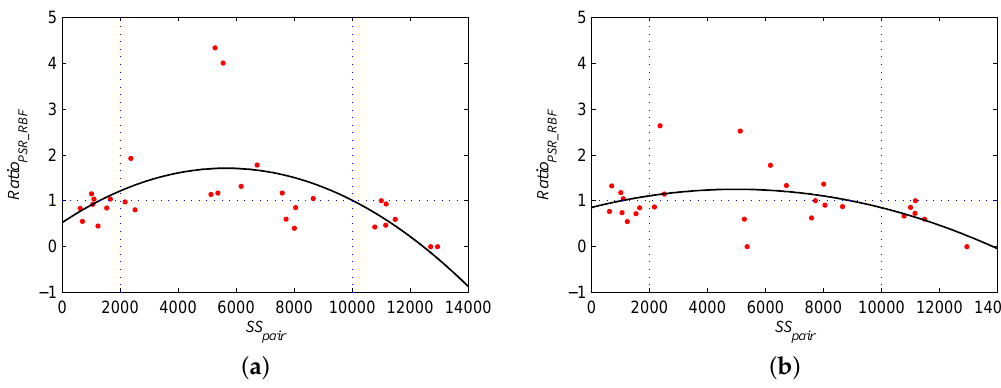
Figure 12. Curves of Ratio PSR _ RBF ( i , j ) when the training set being ( a ) 5% and ( b )